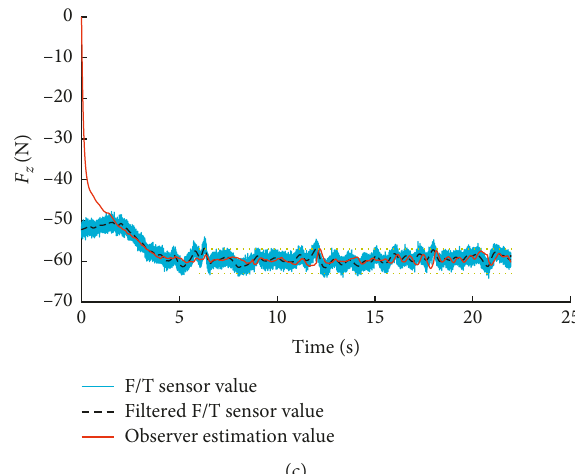
Figure 10: Control performance of the disturbance observer-based hybrid sliding mode impedance controller in the Z direction. The desired force is set to (a) − 30N, (b) − 40N, and (c) −